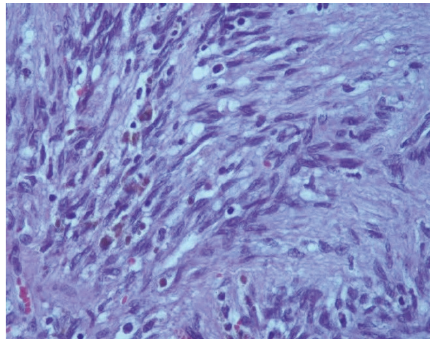
Figure 3: The lesion contains hemosiderin pigments (HE, 400x).